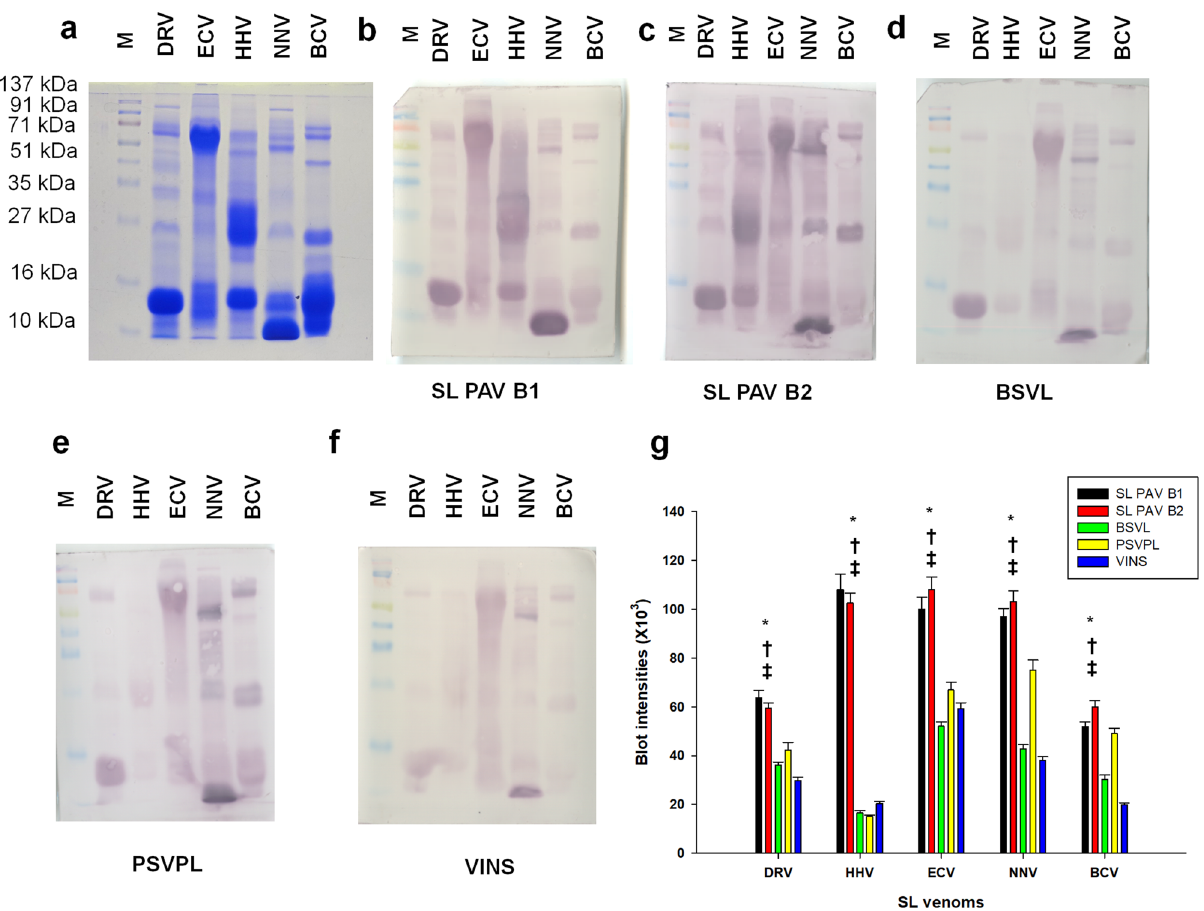
Figure 5. Immunoblot cross-reactivity of SL venoms. ( a ) SDS-PAGE images of SL venoms. ( b – f ) Western blot images of SL venoms against two batches (B1 and B2) of SL PAV, and Indian PAVs (BSVL, PSVPL, and VINS). ( g ) Densitometry analyses of immunoblots as shown in ( b – f ) Values are mean ± SD of duplicate determinations. *Significant difference between SL PAV B1 and B2 with respect to BSVL; † Significant difference between SL PAV B1 and B2 with respect to PSVPL; ‡ Significant difference between SL PAV B1 and B2 with respect to VINS (p < 0.05). Same molecular marker (M) was used for all the blots. The Ponceau stained blot images are shown in supplementary Fig. S8. The full length unedited blot images are shown in supplementary Fig.